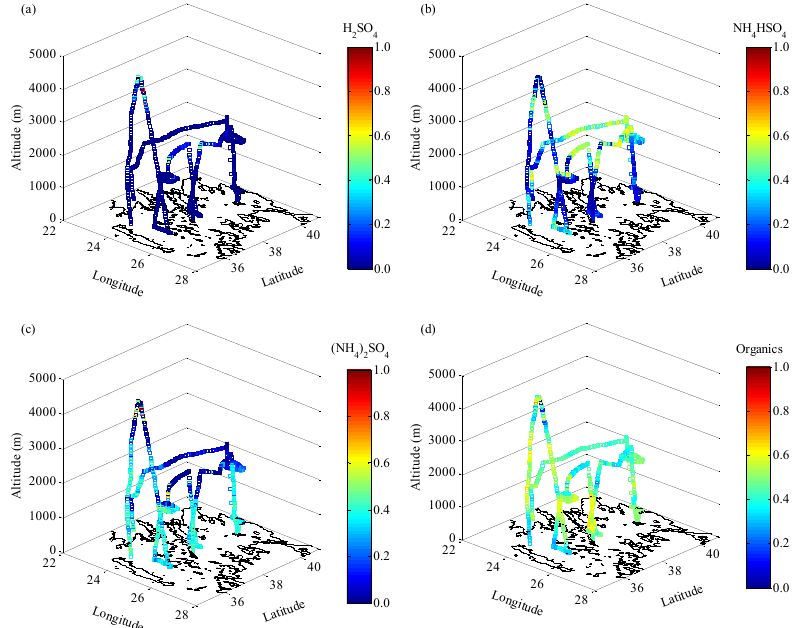
Fig. 7. Composition of the non-refractory compounds measured by the cToF-AMS during the flight performed on 1 September 2011 (flight b637) over the Aegean Sea. The reported volume fractions for H 2 SO 4 (a) , NH 4 HSO 4 (b) , ( NH 4 ) 2 SO 4 (c) and organic matter (d) are estimated using the mole fractions determined by the cToF-AMS measurements and the simplified ion pairing algorithm proposed by Gysel et al. (2007).